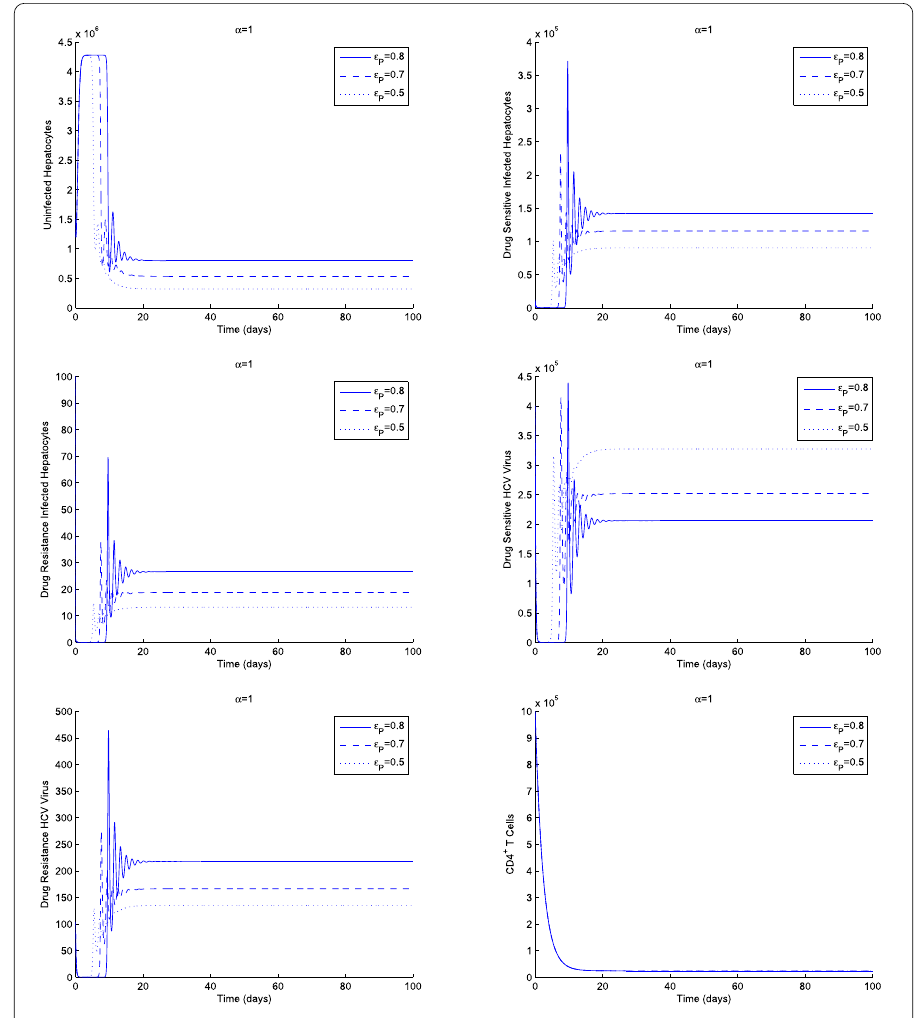
Figure 5 Dynamics of the variables of system (1) for different values of (cid:3) P , the protease inhibitor drug efficacy, and α = 1.0. Parameter values are in Table 1 and initial conditions are given in the text.